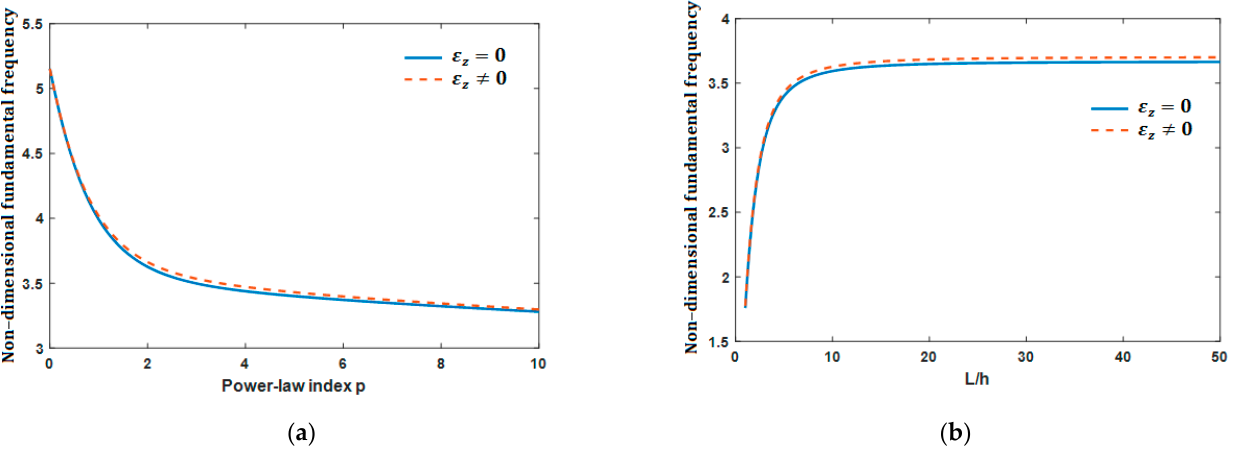
Figure 12. Effect of ( a ) the material parameter and ( b ) slenderness ratio ( L / h ) on the dimensionless fundamental frequency of the S-S FG beam.